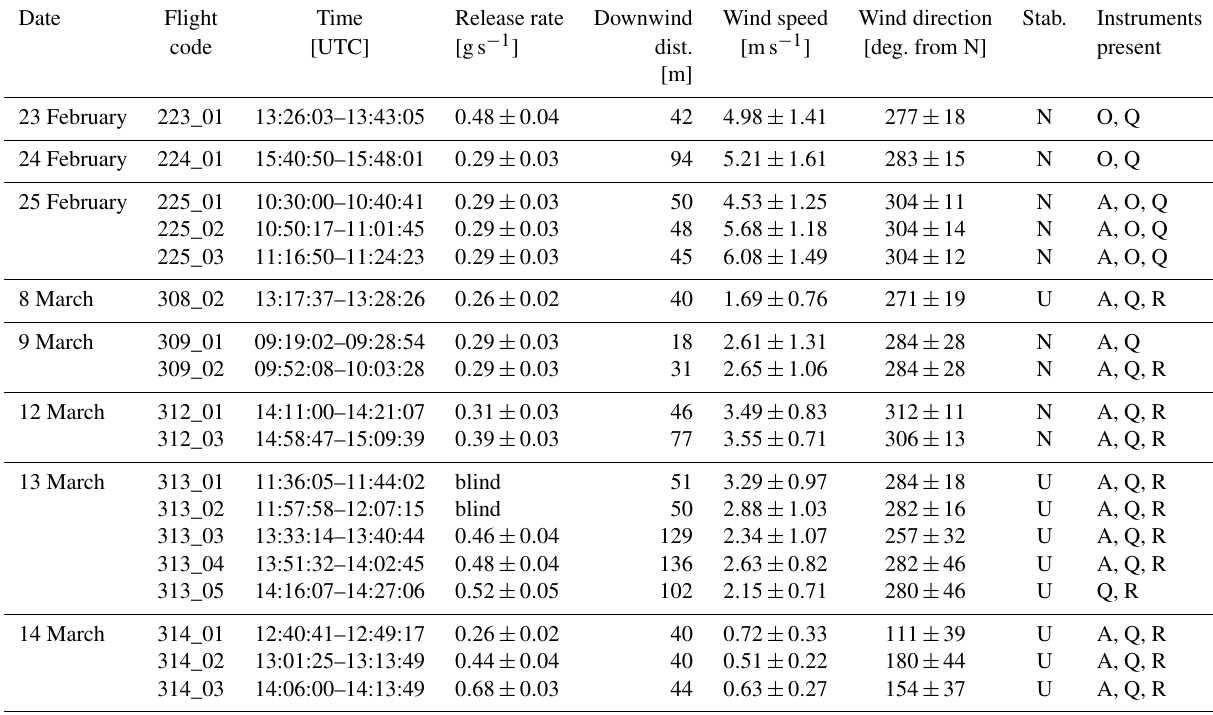
Table 1. Overview of MethAne Release Experiment (MATRIX). Date Flight Time Release rate Downwind Wind speed Wind direction Stab. Instruments